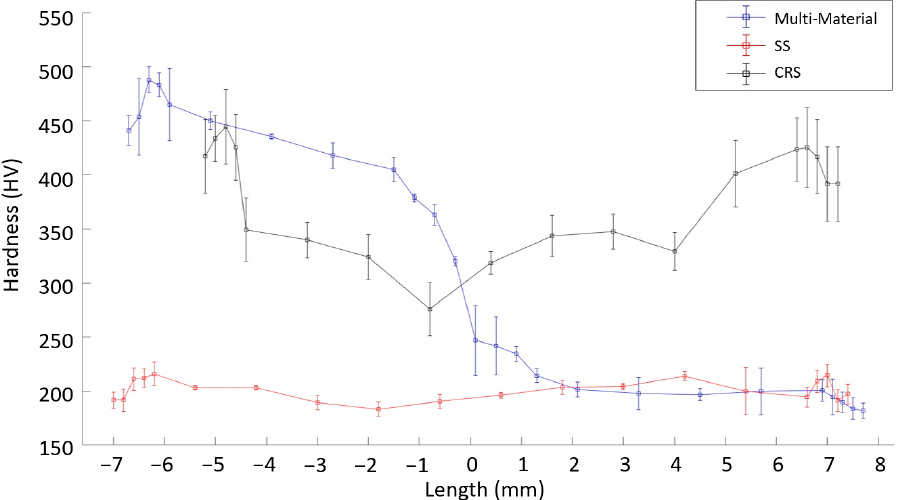
Figure 23. Hardness variation throughout various components (length of 0 indicates midpoint).